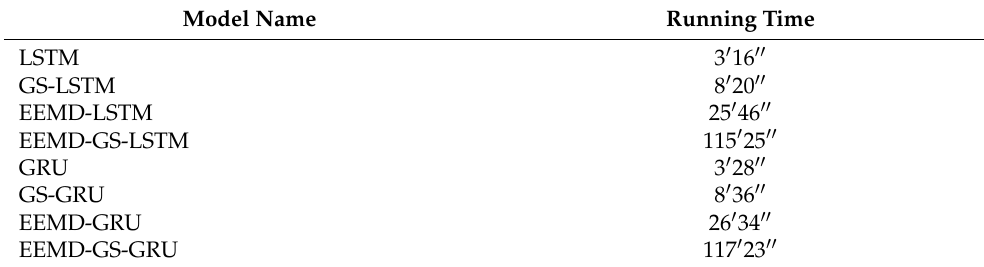
Table 3. The running time of model.